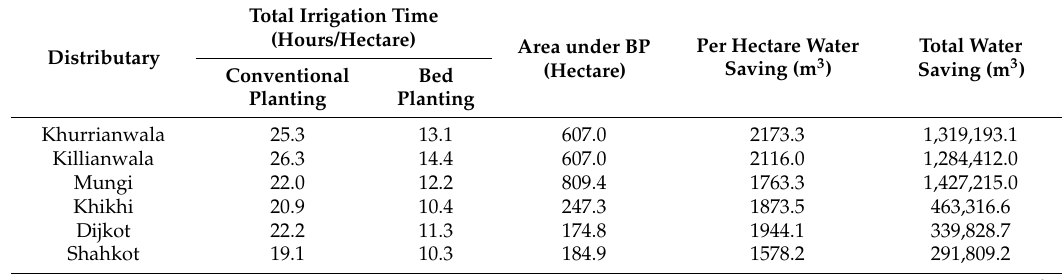
Table 5. Water savings from four irrigations of wheat under bed-planted field.